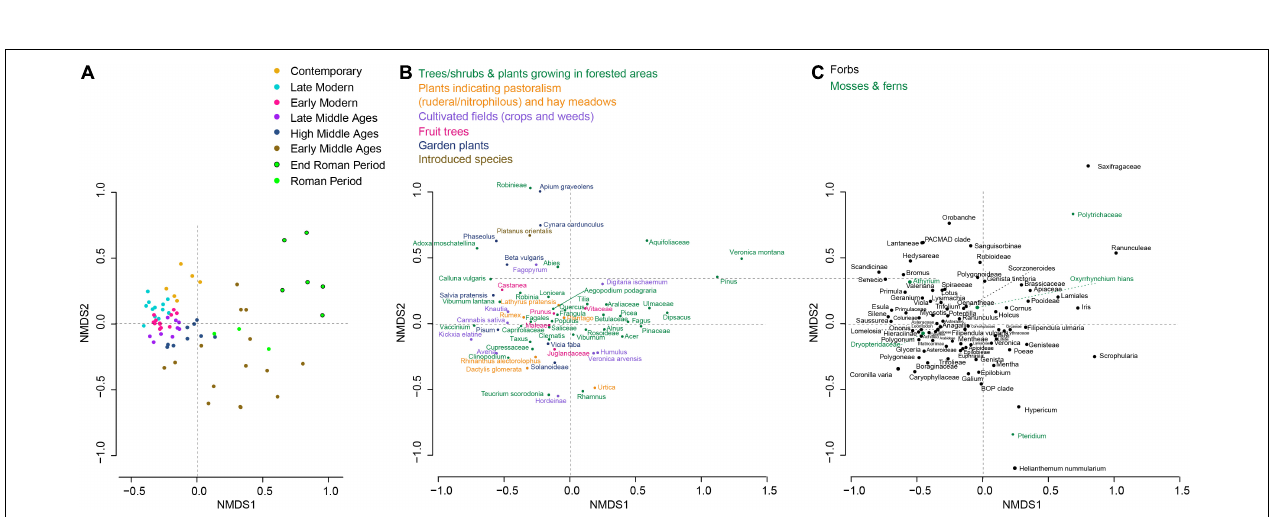
Frontiers in Ecology and Evolution |